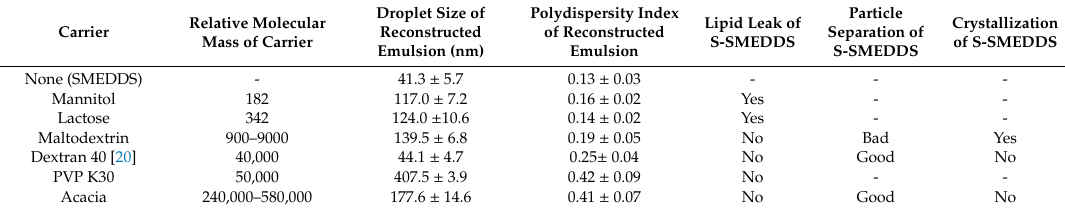
Table 1. E ff ects of hydrophilic carriers on in vitro properties of S-SMEDDS ( n = 3, x ± SD). Droplet Size of Reconstructed Carrier Relative Molecular Mass of Carrier